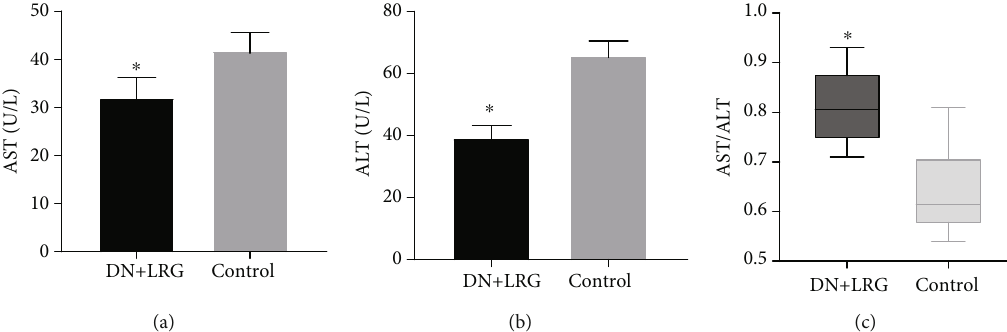
Figure 4: Levels of transferases in the blood. Control: diabetic nephropathy group; DN+LRG: diabetic nephropathy+liraglutide group; ALT: alanine aminotransferase; AST: aspartate aminotransferase. ∗ P < 0 : 05 vs. the control.